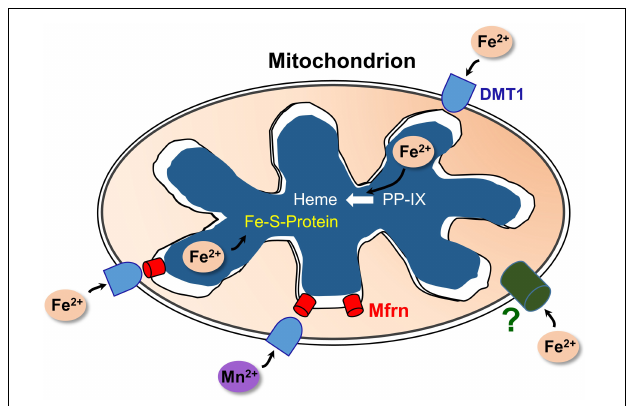
FIGURE 2 | A model of DMT1 participating in mitochondrial iron homeostasis. Keys: DMT1, mitoferrins (Mfrn), ferrous iron (Fe 2 + ), Mn 2 + , iron-sulfur cluster proteins (Fe-S-Protein), protoporphyrin IX (PPIX), and heme. Fe 2 + enters the OMM via DMT1 and an as-yet unidentified pathway (?); while Mn 2 + apparently relies primarily on DMT1 for import. After entry, the two cations could enter the IMS then pass through Mfrn (lower right) or move directly through Mfrn (lower left). Adapted and redrawn with permission from Garrick and Thévenod